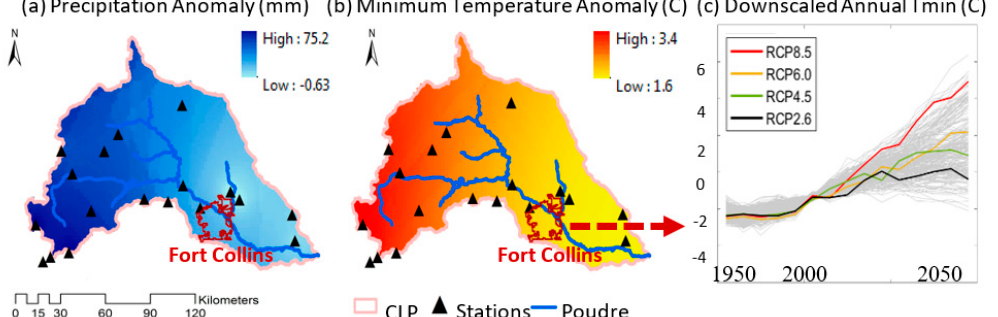
Figure 4. Mid-century (2035–2065) ( a ) precipitation anomaly for the CLP watershed; ( b ) minimum temperature anomaly for the CLP watershed; and ( c ) average annual minimum temperature time series for the City of Fort Collins meteorological station corresponding to the 230 climates.